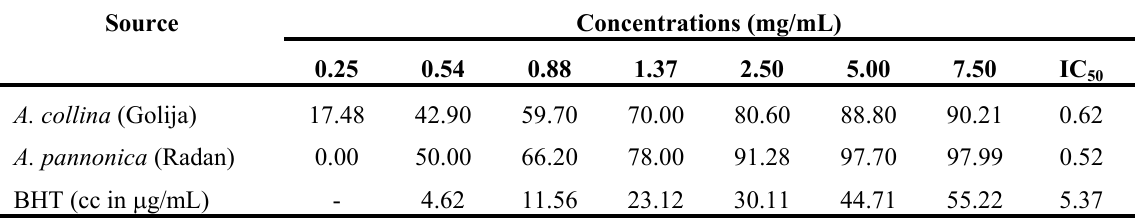
Table 2a. Neutralisation of DPPH by A. collina s.l. and A. pannonica essential oils and BHT (as a positive control) in the DPPH assay (results are expressed in percentage